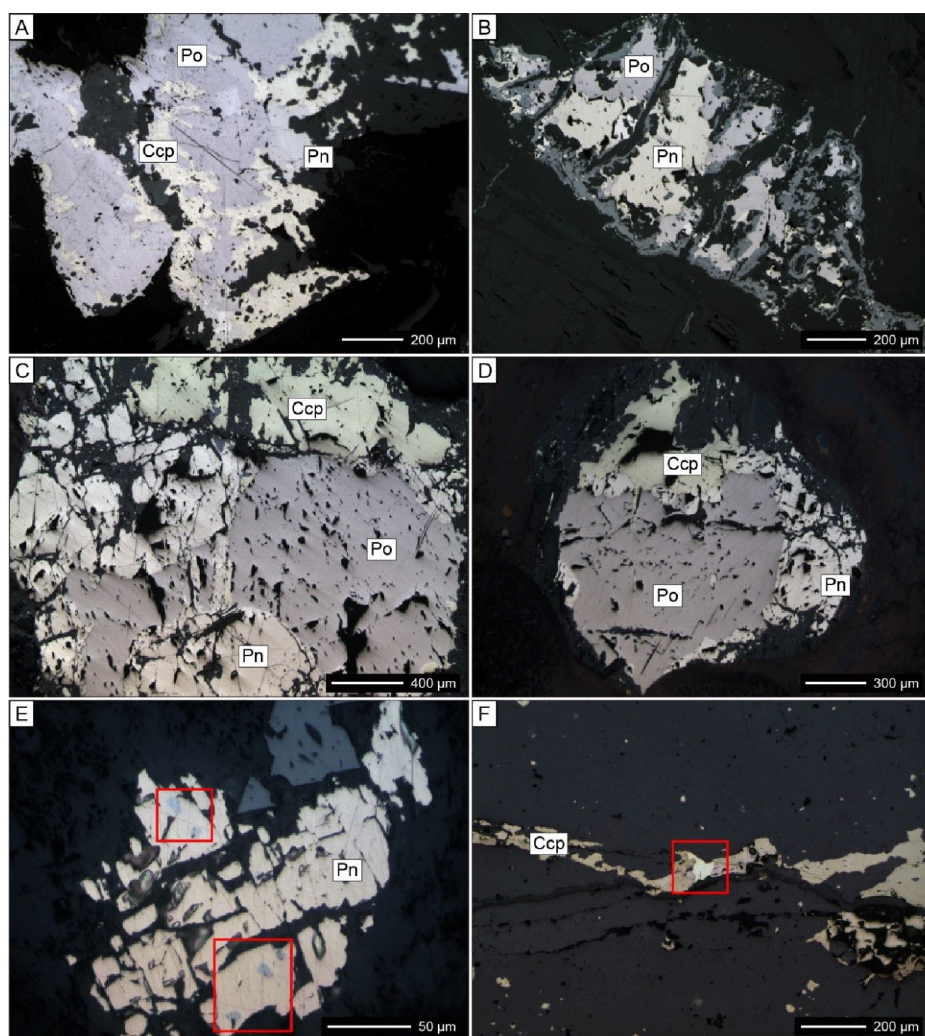
Figure 5. Sulphide textures. ( A ) Disseminated sulphides with serrated grain boundaries; ( B ) Sulphide relics displaying replacement along the rim and fractures by magnetite and serpentinite indicating post-solidification replacement. ( C ) Differentiated globular sulphide characteristically showing pyrrhotite and pentlandite at the base separated by a smooth meniscus from chalcopyrite at the top of the bleb. ( D ) Clinopyroxene-capped differentiated sulphide globule with a flat base. ( E ) Pentlandite relics within a serpentine matrix displaying inclusions of Pd-bismuthotellurides (within red boxes). ( F ) Chalcopyrite bearing veinlet with gold grain (Mineral abbreviations follow [68]).